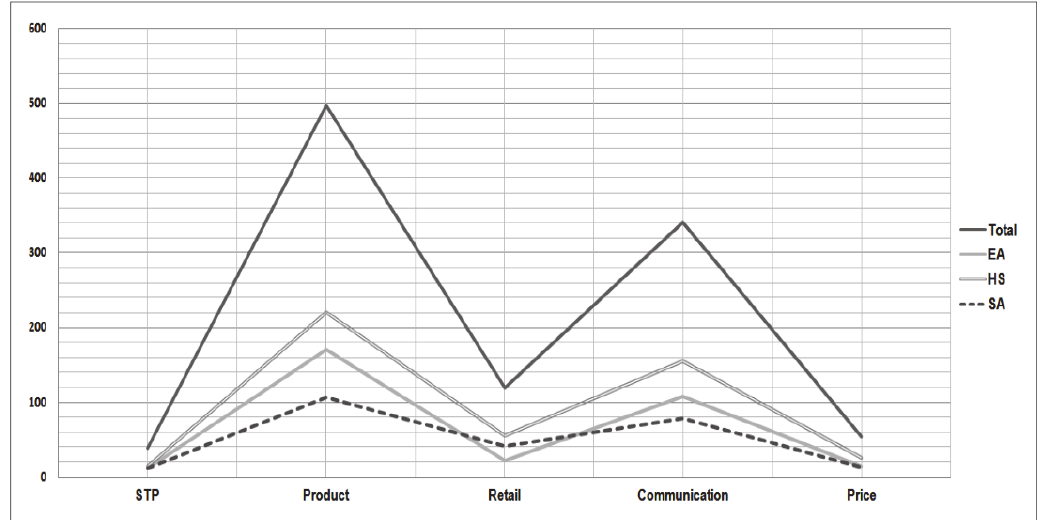
<Figure 7> Distribution of Publications on STP &